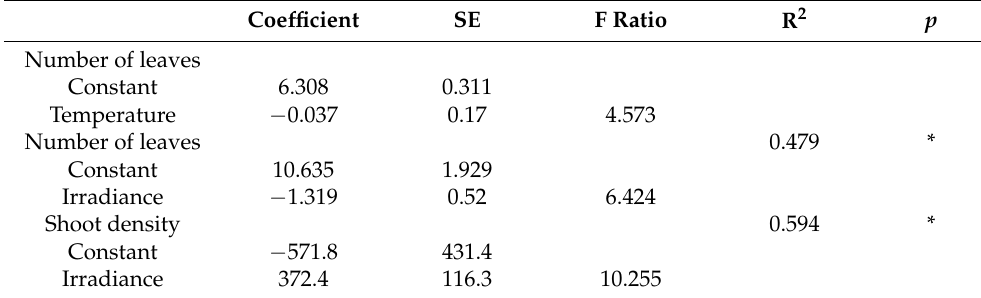
Table 4. Results of regression analyses of Posidonia oceanica for shoot density and number of leaves with irradiance (for only one annual cycle) and surface seawater temperature. Only environmental variables accepted in each regression model ( p < 0.05) are listed. * p < 0.05. F Ratio